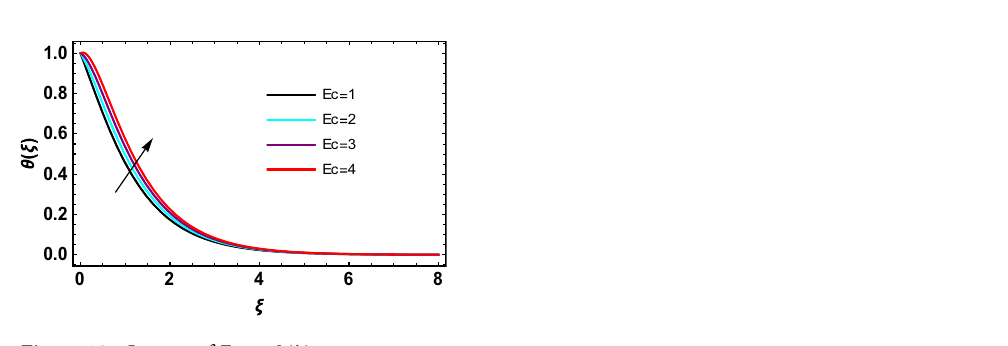
Figure 13. Impact of Ec on θ(ξ)